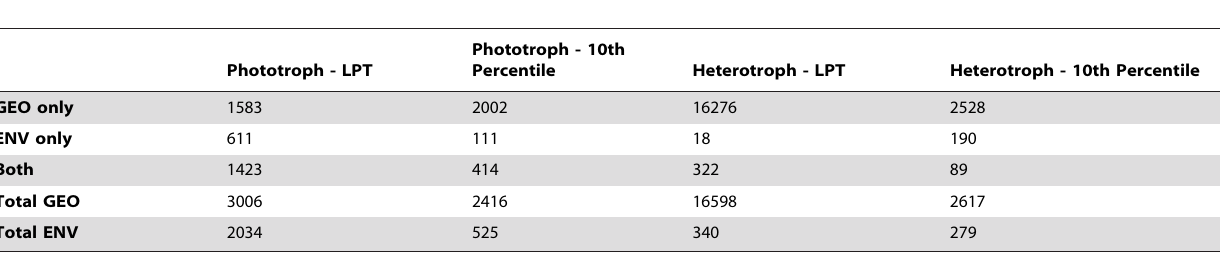
Table 1. Estimated habitat area for phototroph and heterotroph communities using both Lowest Presence (LPT) and 10 th Percentile thresholds in square km (km 2 ).